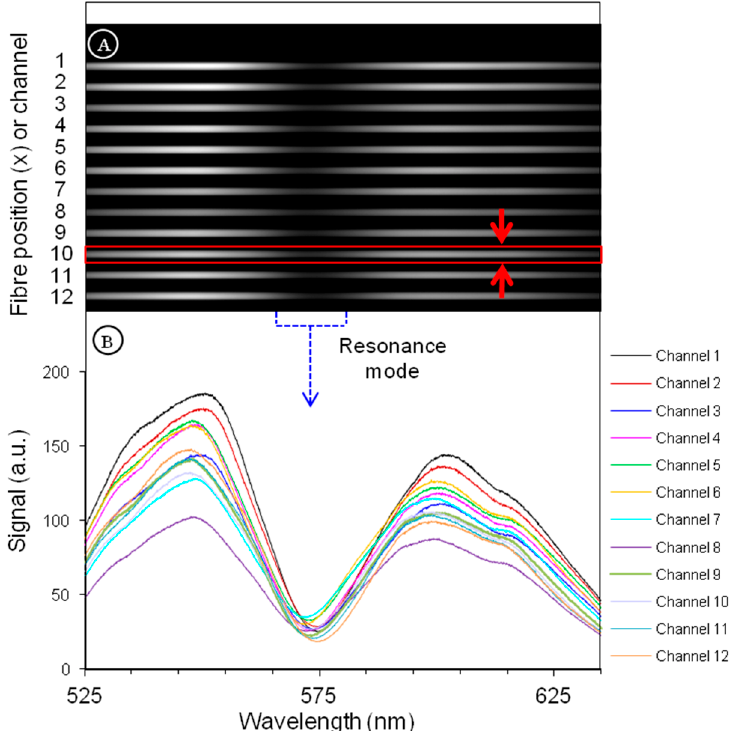
Figure 7. ( A ) Full field image captured by the camera. Each horizontal gray track corresponds to a spectrum of a BICELL. The shadow area in the middle of the image corresponds to the position of the resonance mode (it is a dip because light is transmitted through the BICELL at resonance). The height of the red rectangle around channel 10 illustrates the pixel length (~50 pixels) over which the signal is integrated to obtain the one dimensional spectra. ( B ) Extracted one dimensional spectra from the image. Each dip is fitted with a Lorentzian (not shown) in order to extract the resonance position with a high precision.